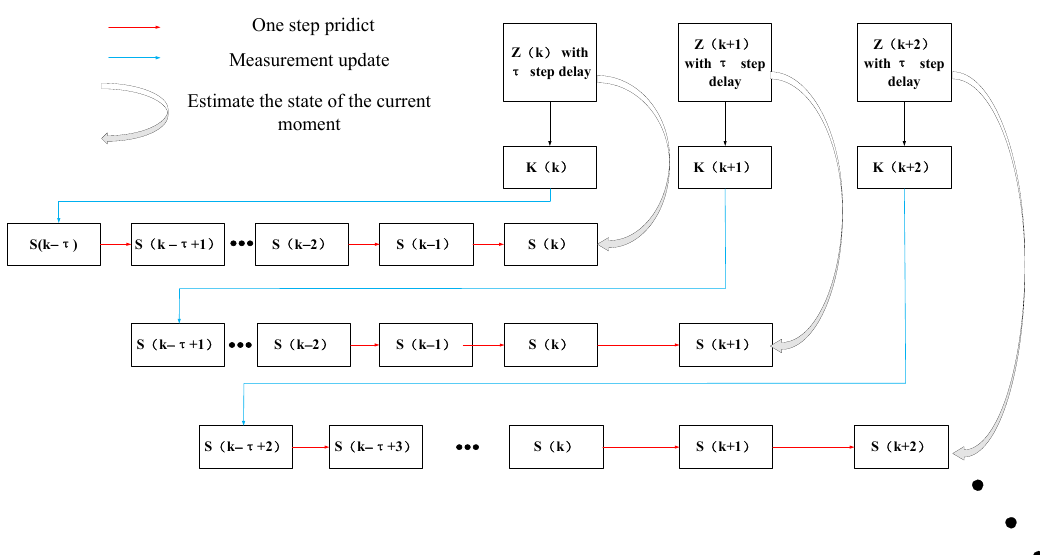
Figure 5. Flow diagram of the proposed algorithm.